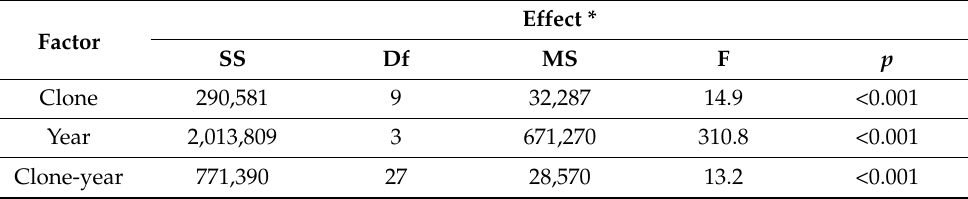
Table 7. The results of the two-way variant analysis (F-test) of the influences of clones and years on the number of apterous Metopolophium dirhodum (Walk.) (July